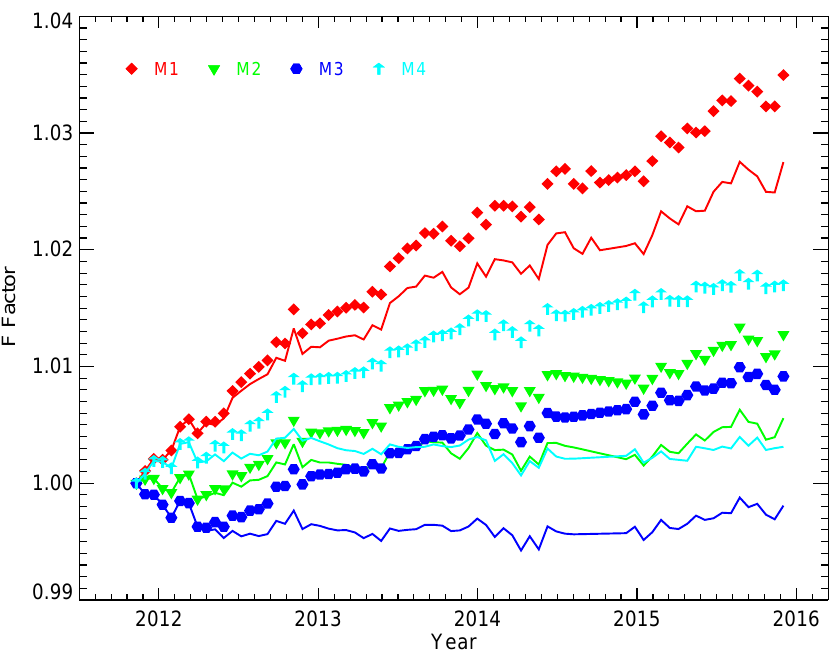
Figure 14. Band-averaged hybrid F-factors (symbols) and band-averaged SD F-factors (lines).